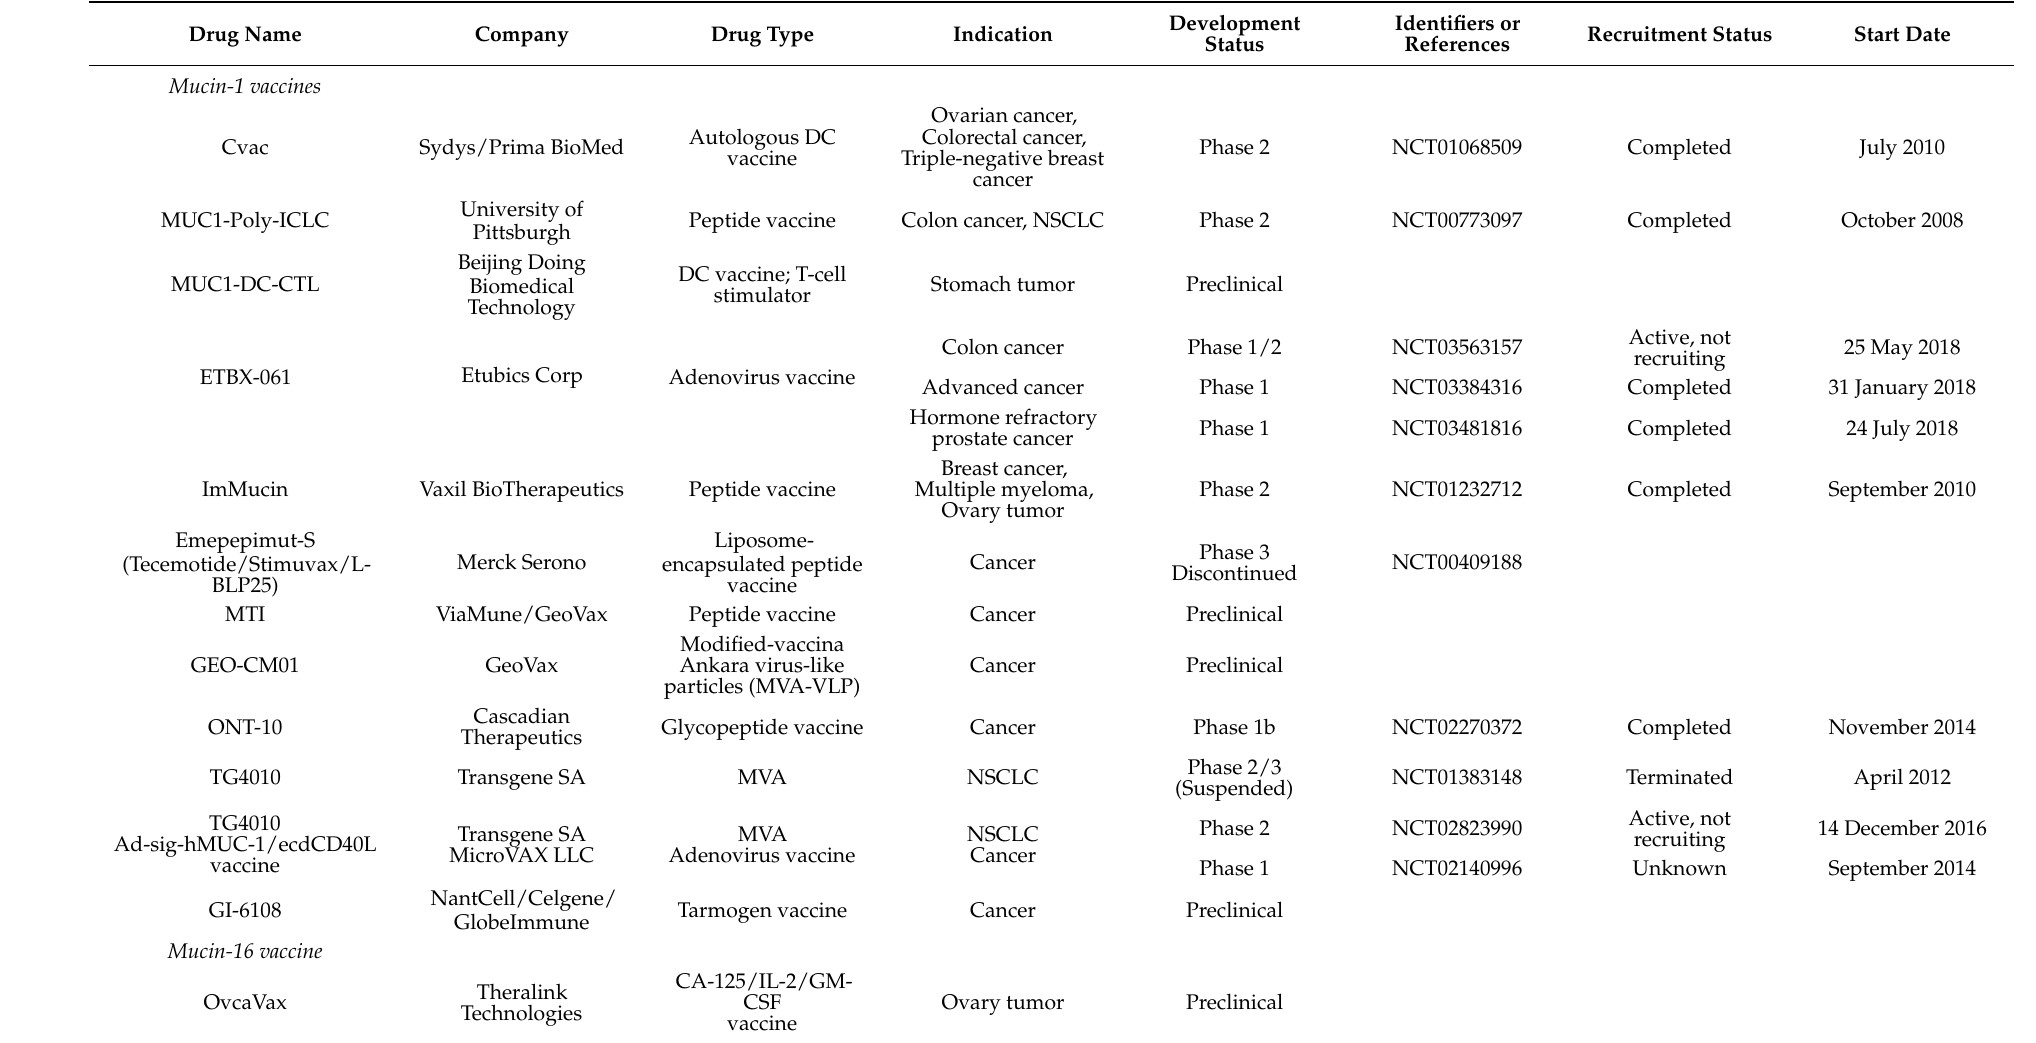
Table 3. Tumor vaccines that target mucin family